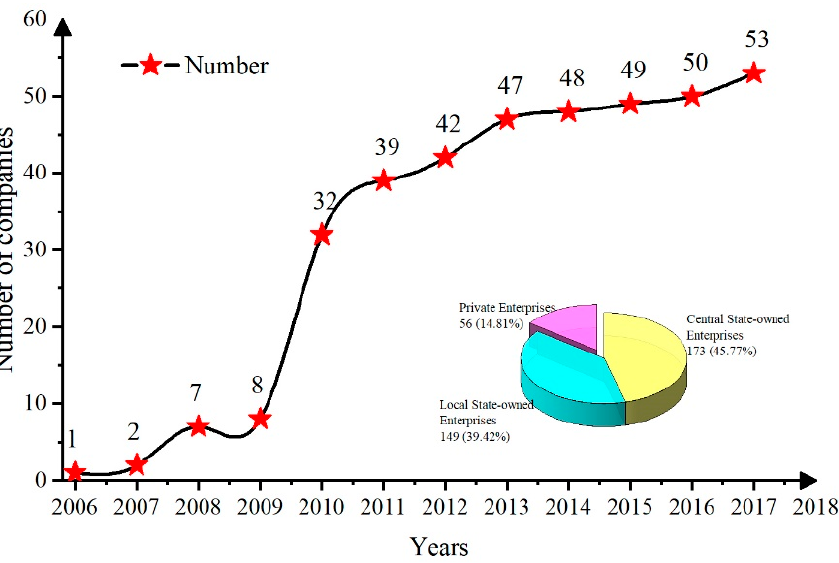
Figure 3. Quantity distribution of energy saving and environmental protection information